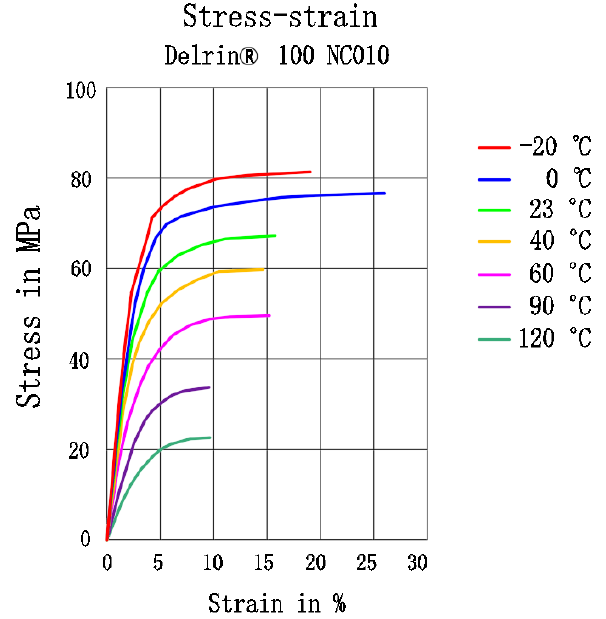
Figure 1. Typical stress-strain curve of POM. According to the suggestion from American Gear Manufacture Association (AGMA), the plastic gear tooth profile is shown in Figure 2 [14].